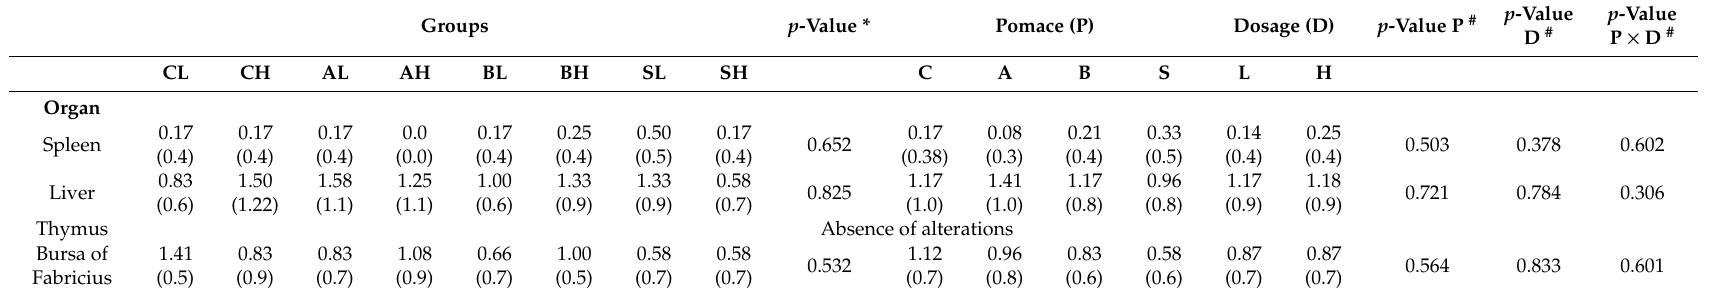
Table 6. Histopathological scores of spleen, liver, thymus and bursa of Fabricius.